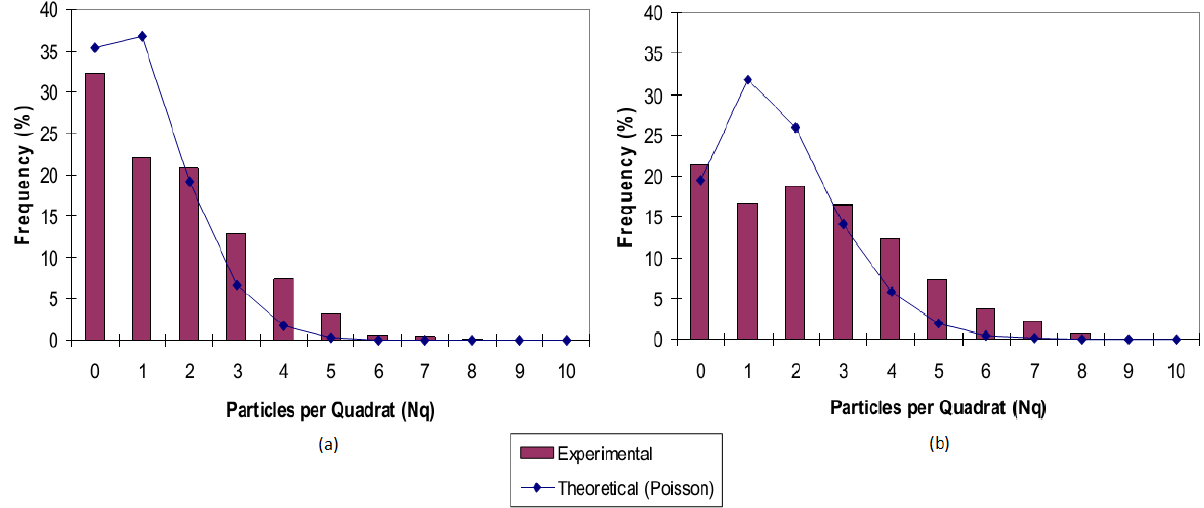
Figure 20. Particle distribution of SiC particles in Zn-Al matrix ( a ) heat treated; ( b ) 35% cold rolled [104].